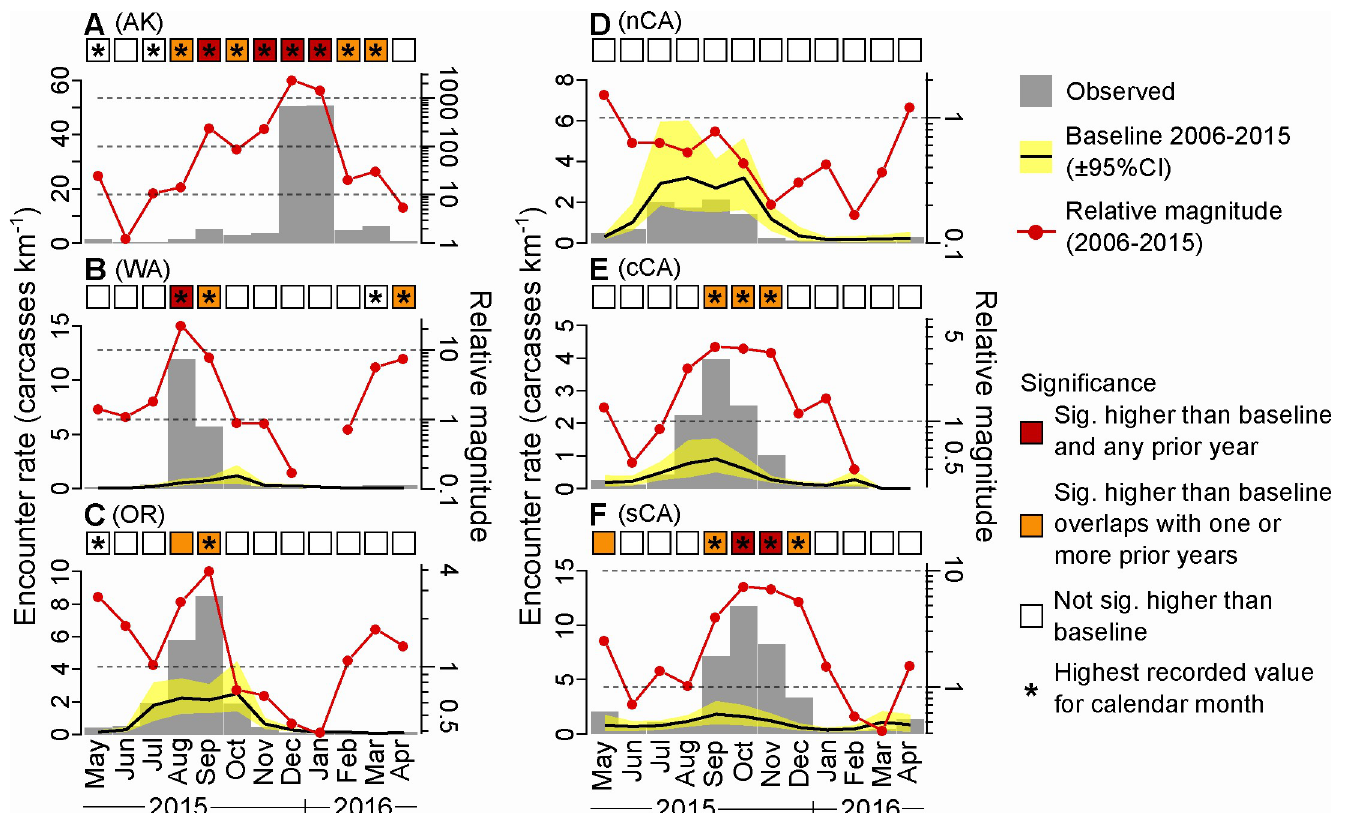
Fig 3. Monthly averaged encounter rates (carcasses per km, gray bars) for the (A) Gulf of Alaska, (B) Washington, (C) Oregon, (D) northern California, (E) central California, and, (F) southern California coastlines. Black lines are baseline encounter rates, yellow shadings are 95% confidence intervals, and red lines show relative magnitude of encounter rates in 2015/2016 compared to the 2006–2015 baseline. Colored squares indicate whether month-averaged encounter rate was significantly higher than baseline and whether they were significantly higher than any prior year of data collection for that calendar month. Asterisks indicate that the mean encounter rate in the corresponding month was the highest value ever recorded. Note that the GOA baseline is so low that it cannot be seen on the chart. Relative magnitude was calculated as the 2015/2016 encounter rates divided by the baseline mean